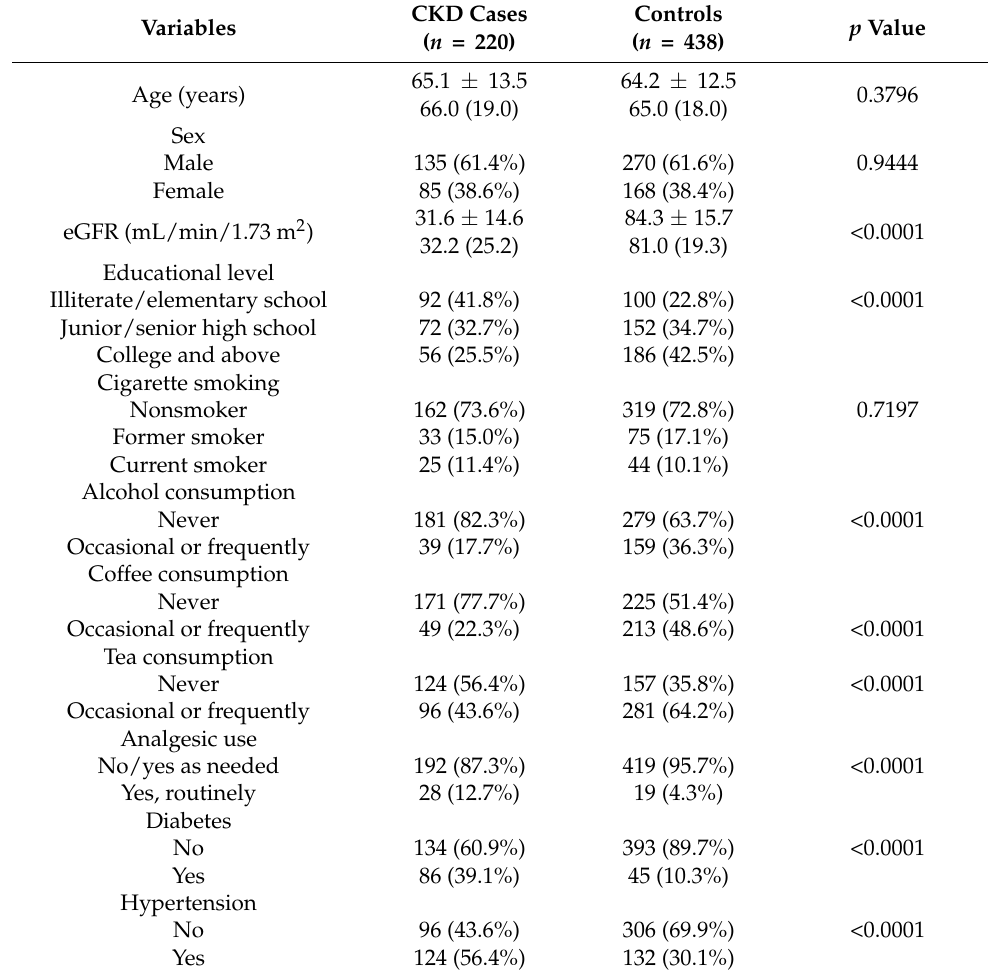
Table 1. Sociodemographic characteristics, lifestyle, and disease histories of CKD cases and